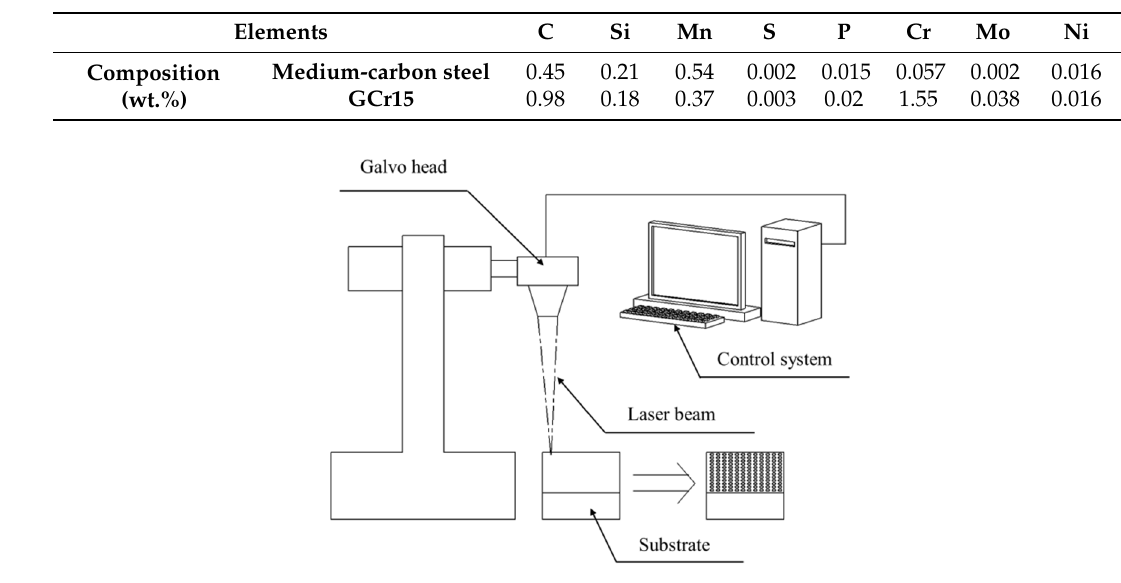
Table 1. The chemical constituents of medium-carbon steel and GCr15 were analyzed by EDS.